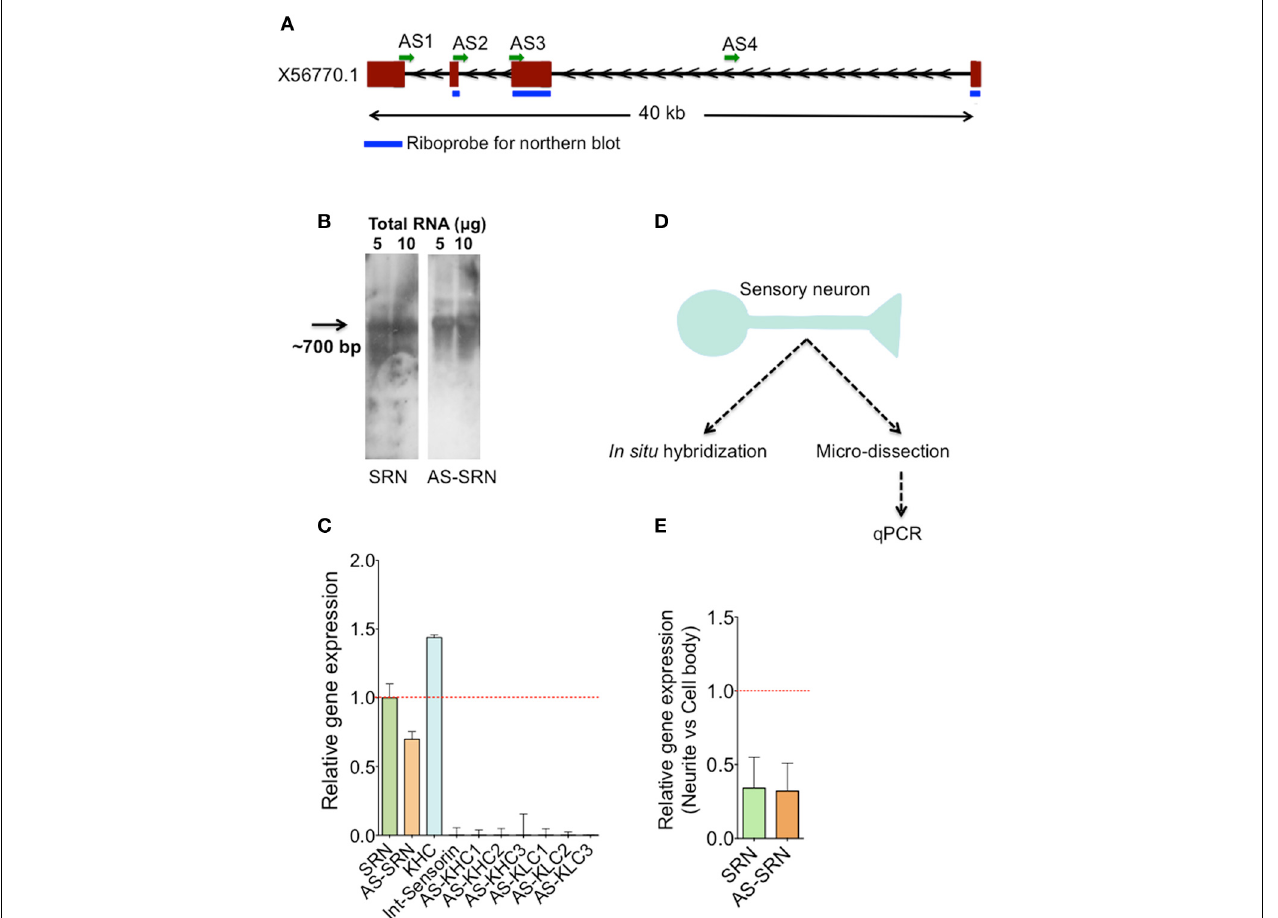
FIGURE 1 | Identification of natural antisense transcripts of neuropeptide sensorin. Arrows indicate the direction of transcription. (A) The psc1 gene (EST X56770) coding for sensorin mRNA has four exons spanning ∼ 40KB on the scaffold 926 of Aplysia . AS1-4 represents the locations of qPCR amplicons that are used to detect AS transcript. (B) Northern blot detection of SRN and NAT-SRN from the total RNA of Aplysia CNS using strand specific ribo-probes. (C) qPCR analysis of SRN